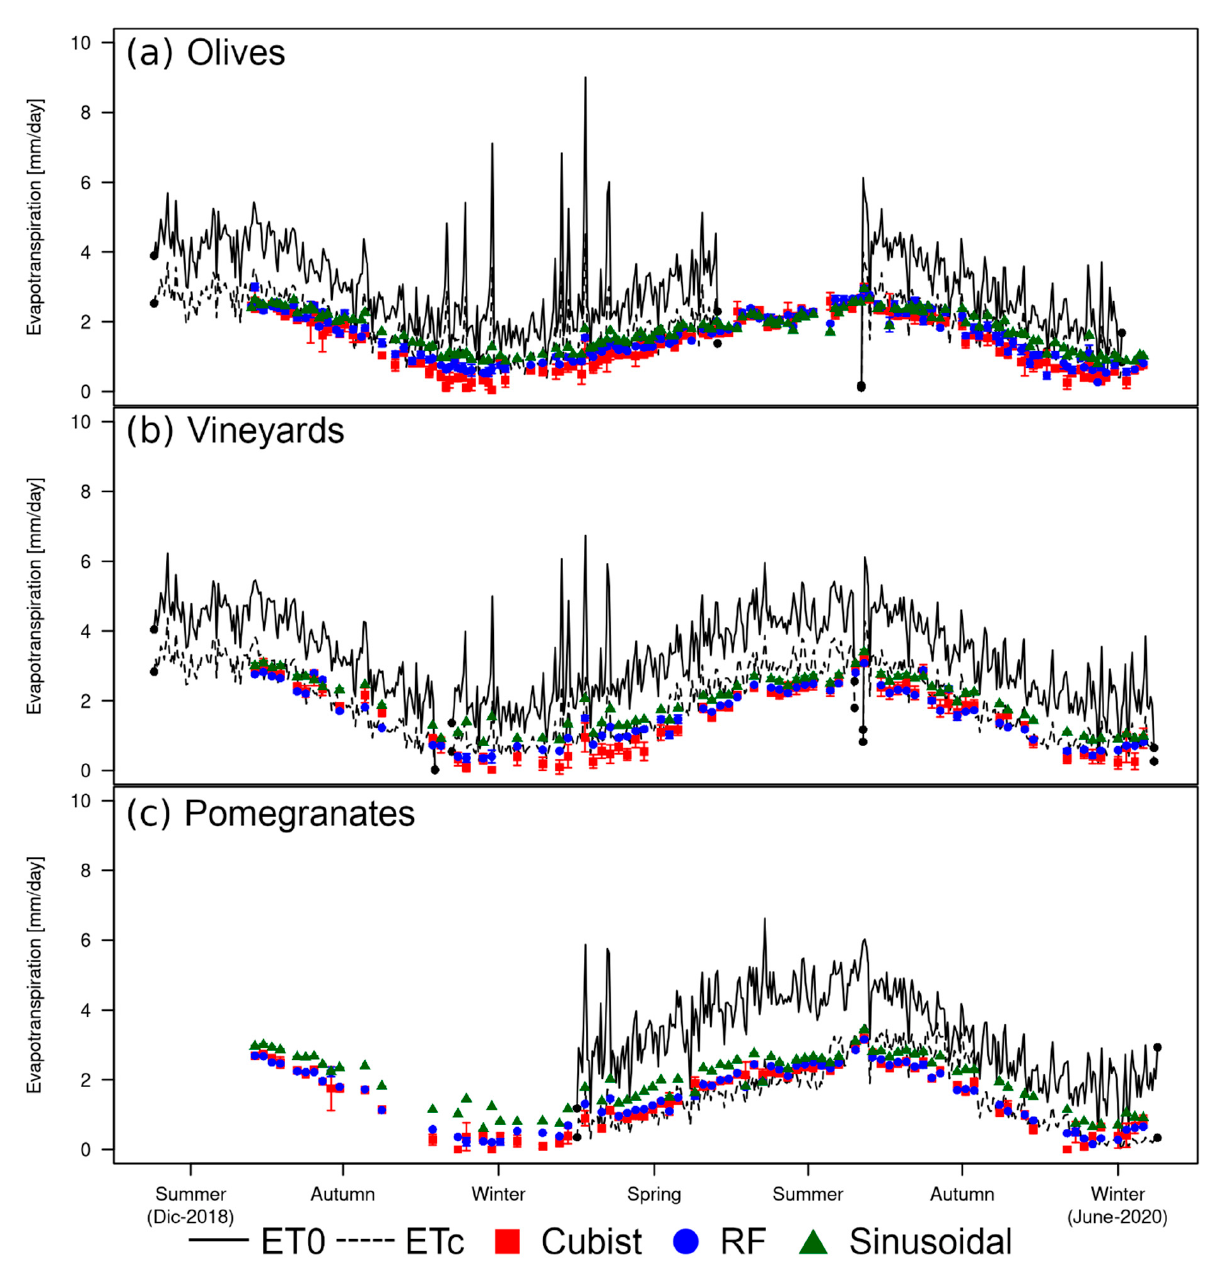
Figure 9. Temporal series of the predicted ETa at 10 m with the cubist, random forest, and sinusoidal models versus the ETa measured by the in situ stations at ( a ) olives, ( b ) vineyards, and ( c ) pomegranates orchards. The error bars are showing the standard deviation of the 9 pixel cells surrounding the ETc station of each ETa model.